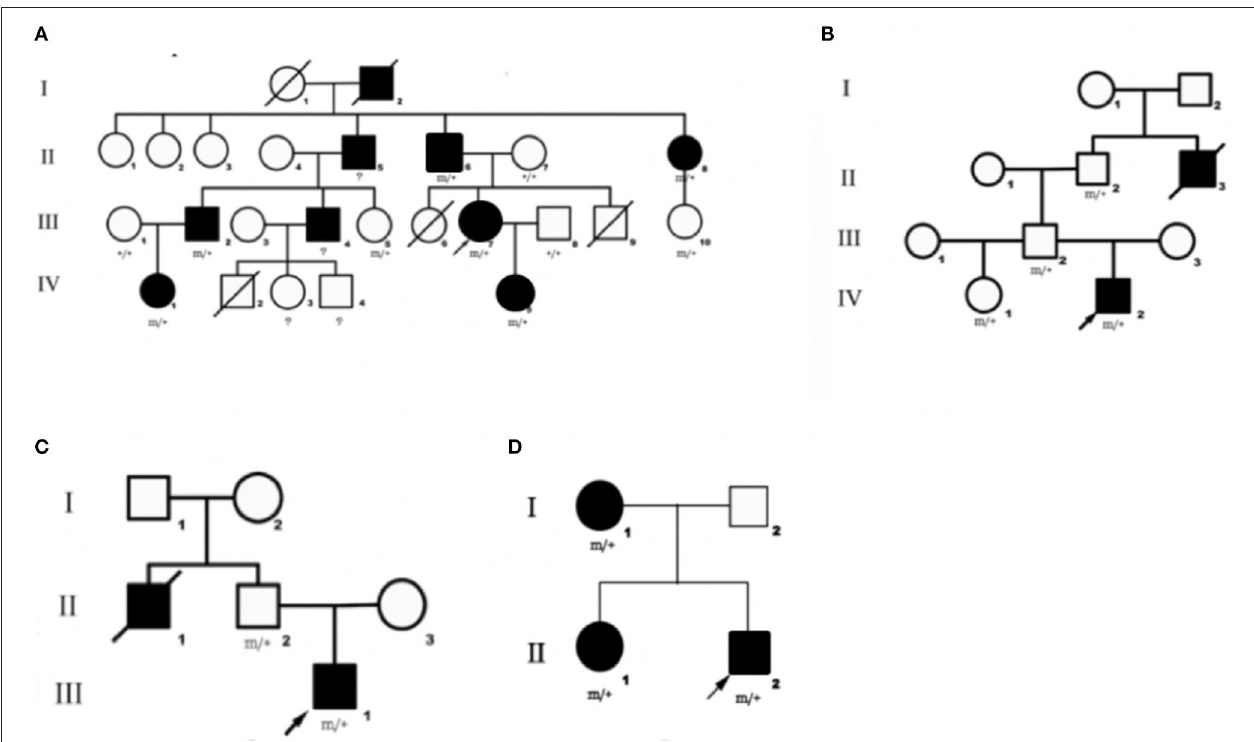
FIGURE 1 | Pedigrees of four families diagnosed with familial focal epilepsy. (A–D) Families 1–4, respectively. Black squares/circles indicate male/female members with epilepsy in the family. Deaths are indicated by slashes. Probands are indicated by oblique arrows. Individuals carrying the DEPDC5 mutation are indicated by (m/ + ). Individuals with negative mutation are indicated by ( + / + ), and individuals without blood samples are indicated by